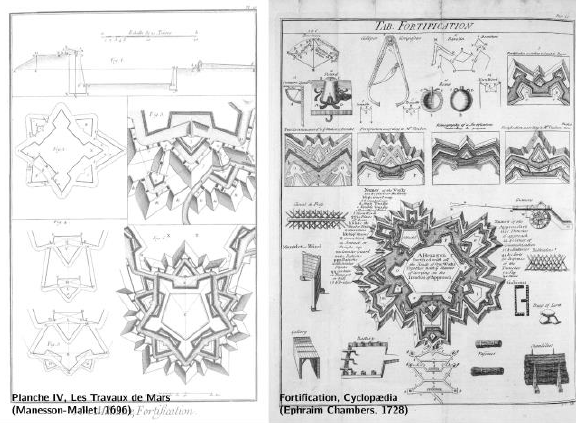
Figure 4. Extract from the bastioned fortification